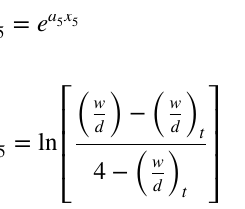
Effect of bit diameter and weight on bit, ( w / d ) The bit weight and bit diameter are considered to have a direct effect on the ROP. The constant a 5 in Eq. 9 represents the effect of WOB and bit diameter on the penetration rate. The param- assumes that the ROP is directly proportional to eter x 5 (Bourgoyne and Young 1974).